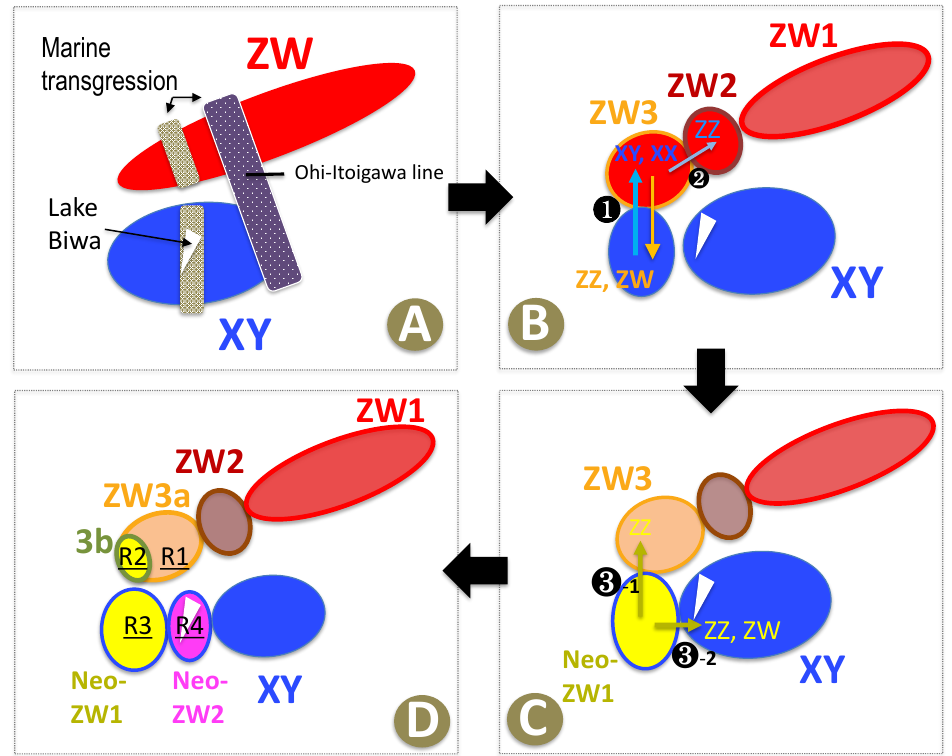
Figure 5. Assumed evolutionary process of geographic differentiation of the ZW and Neo-ZW groups and evolution of the W chromosomes in Glandirana rugosa ( A – D ). Arrows indicate four major emigrations of populations between XY and ZW groups and one emigration from ZW3a to ZW2. R1 – R4 denote four times recycling of the W chromosomes from X chromosomes.